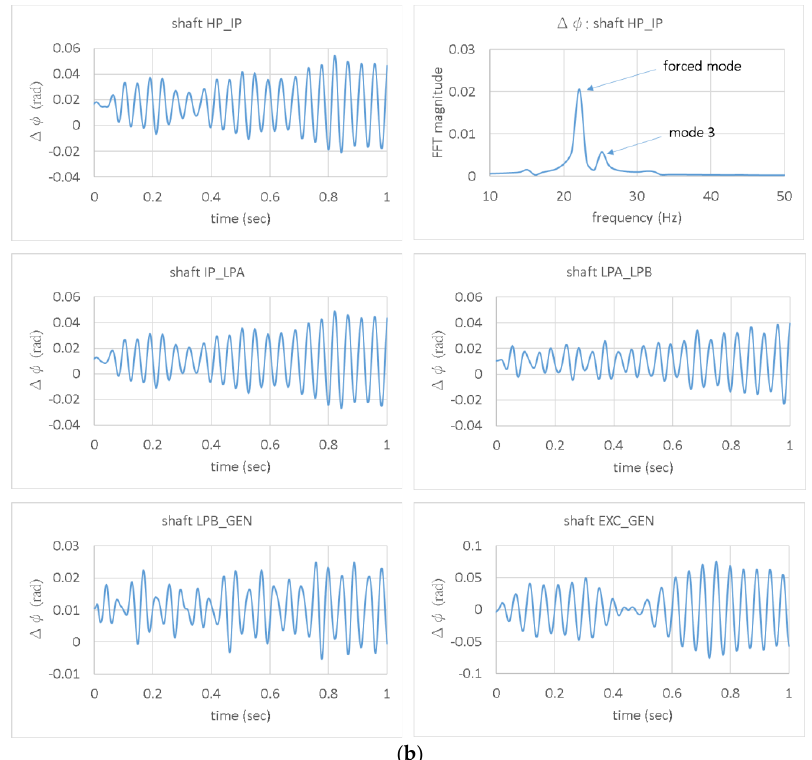
Figure 8. ( a ) Shaft torsional responses for the integration of a 100 MW DFIG wind farm. ( b ) Shaft torsional responses for the integration of a 200 MW DFIG wind farm.